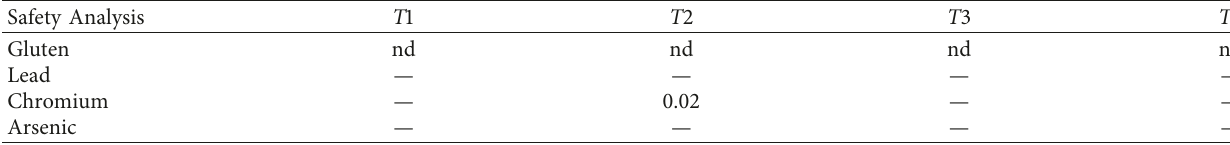
Table 6: Safety analysis of various gluten-free cupcakes and control (mg/L).